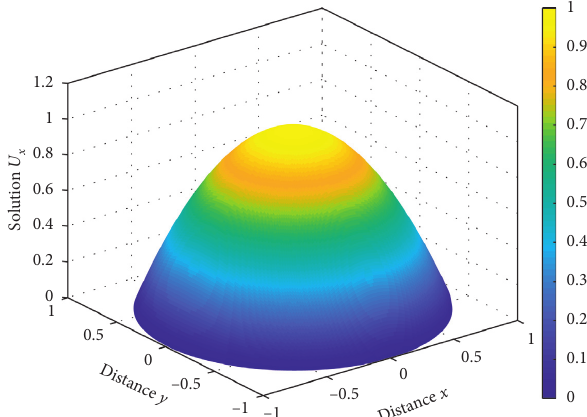
Figure 12: The exact solution with ε � 0 . 01, and max ( u